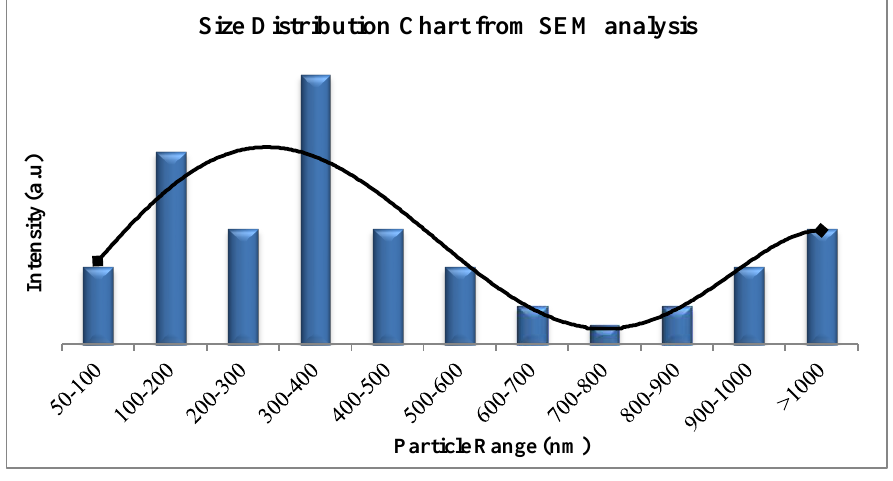
Figure 4. Histogram from SEM Analysis